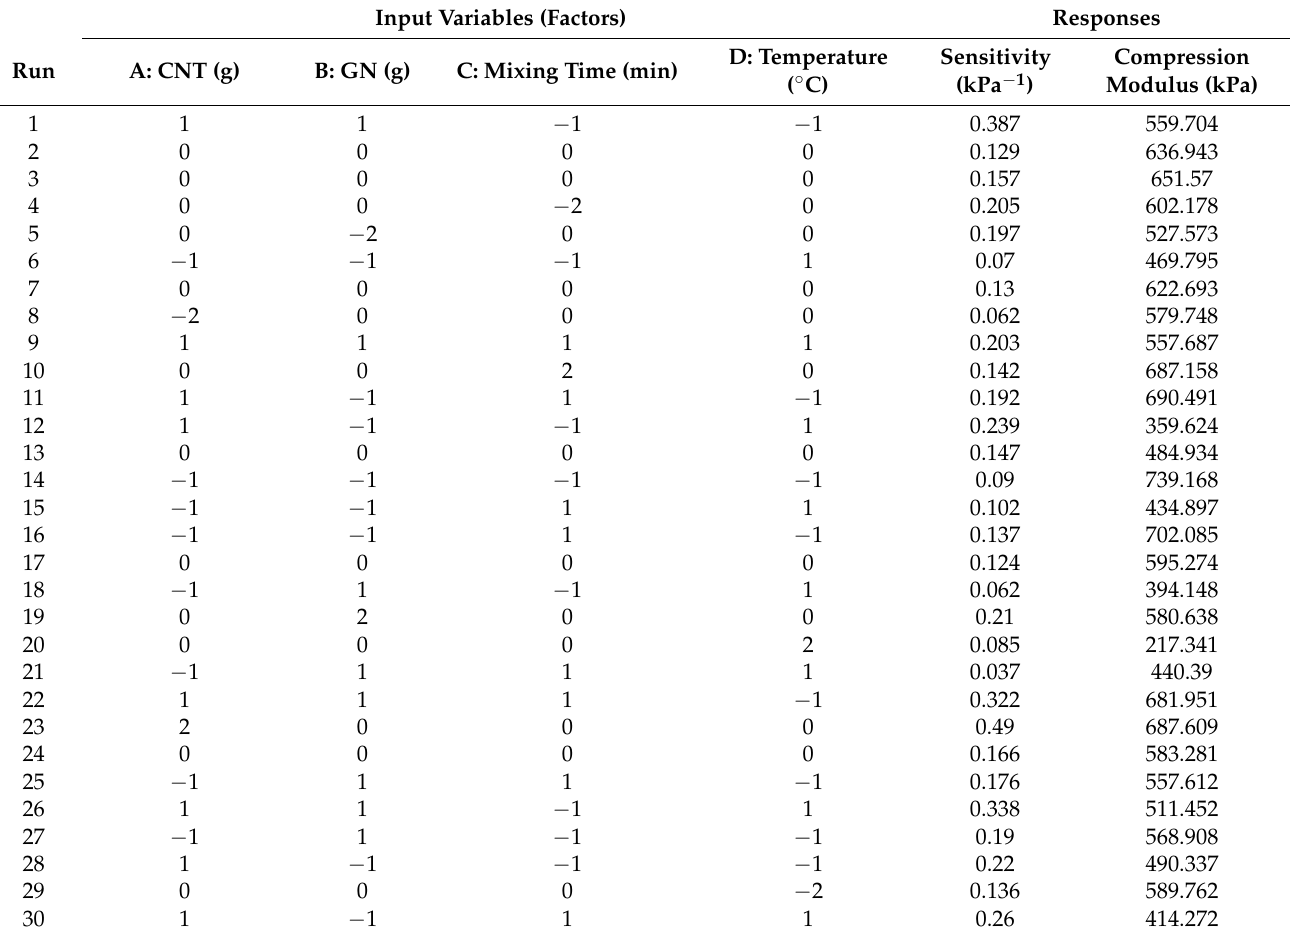
Table 2. Experimental design matrix and the values of responses based on the experiment